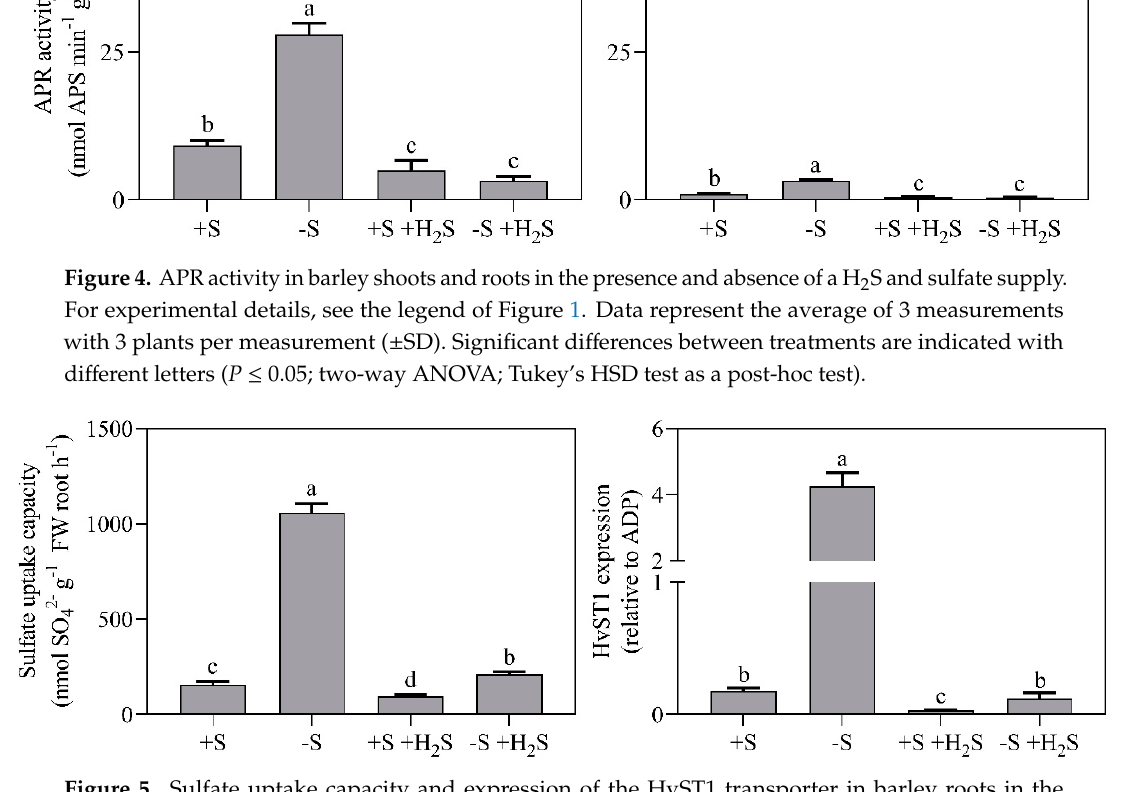
Figure 5. Sulfate uptake capacity and expression of the HvST1 transporter in barley roots in the presence and absence of a H 2 S and sulfate supply. For experimental details, see the legend of Figure 1. Data represent the average of 7 (sulfate uptake capacity) and 3 (HvST1 expression) measurements with 3 plants per measurement (±SD). Significant differences between treatments are indicated with different letters ( P ≤ 0.05; two ‐ way ANOVA; Tukey’s HSD test as a post ‐ hoc test).